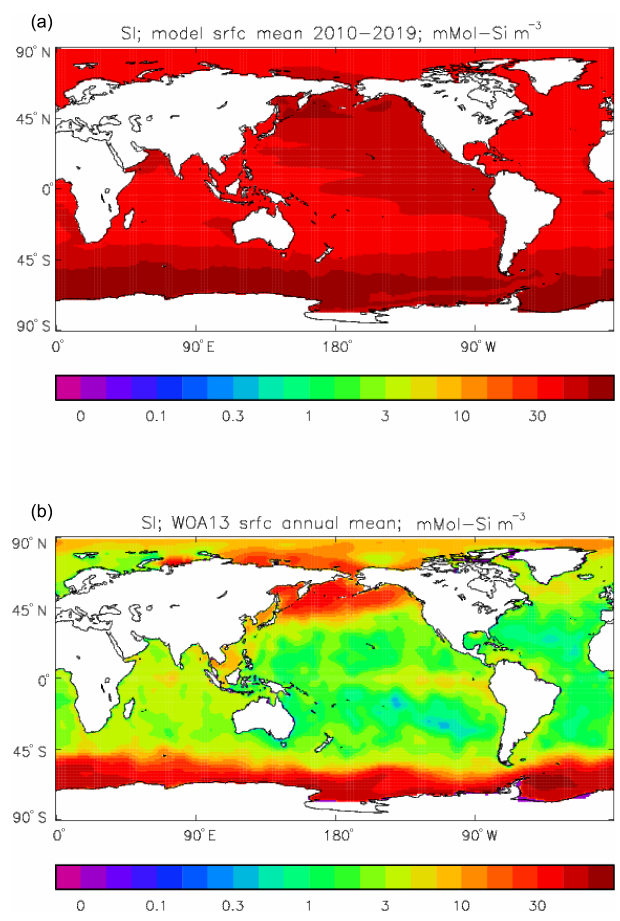
Figure 25. Surface dissolved silicate (mMolSim − 3 ): (a) model field averaged over model years 2010–2019; (b) the gridded field from the 2013 World Ocean